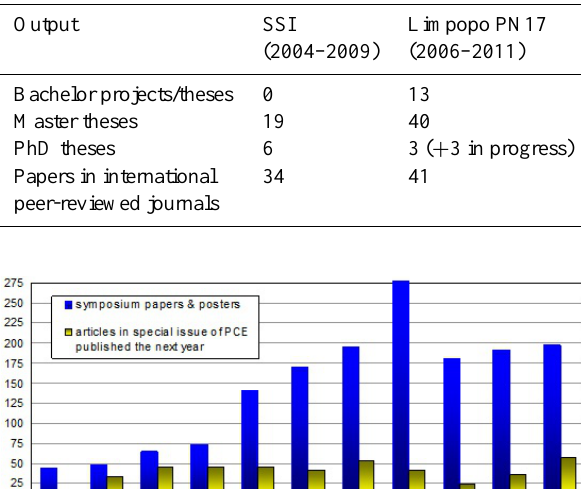
Table 1. Output of two large WaterNet affiliated multidisciplinary